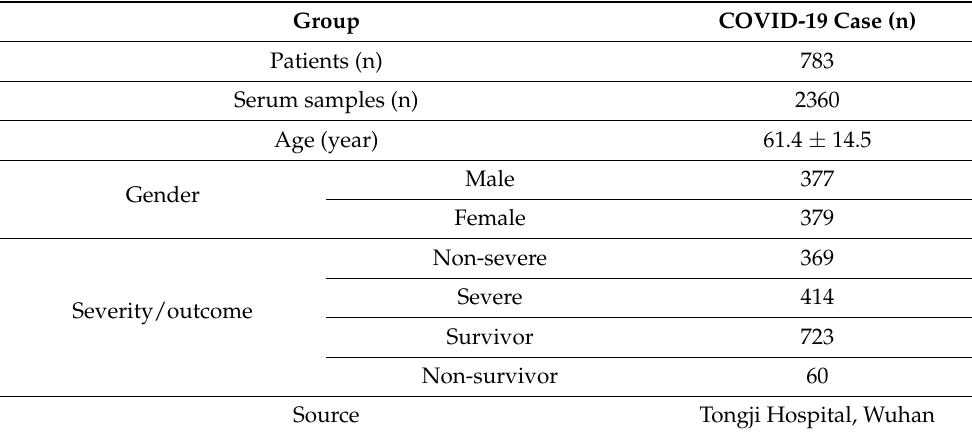
Table 1. The clinical characteristics of the diagnosed COVID-19 patients.